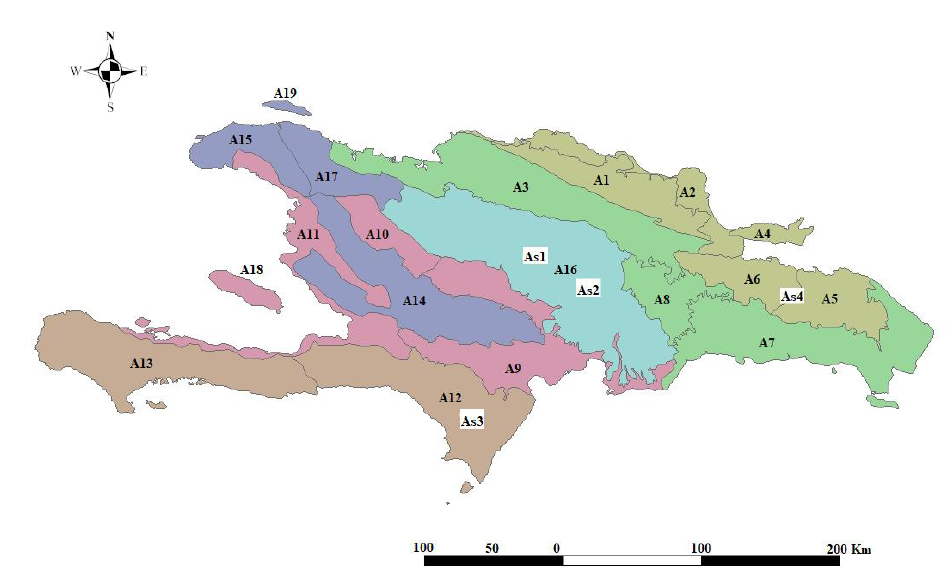
Figure 4. Biogeographical distribution of the associations in the study. As1: Hyeronimo montanae - Magnolietum pallescentis (A16: central district). As2: Cyatheo furfuracei - Prestoetum montanae (A16: central district). As3: Hyeronimo dominguensis - Magnolietum hamorii (A12: Bahoruco district). As4: Ormosio krugii - Prestoetum montanae (A5: eastern district) (from Cano–Ortiz et al., modified [28]). Table 3. Synthetic table of the four new associations considered in this study. Species As1 As2 As3 As4 P Myrsine coriacea (Sw.) R. Br. IV III V III 4 Ocotea leucoxylon (Sw.) Mez I IV III III 4 Prestoea montana (Grah.) Nichol I V V V 4 Psychotria domingensis Jacq. IV IV V III 4 Gleychenia bifida (Willd.) Spreng. II I - I 3 Clidemia umbellata (Miller) L.O. Wms. I I - I 3 Renealmia jamaicensis (Gaertn.) Horan var. puberula (Gagn.) Maas V III V - 3 Arthrostylidium multispicatum Pilger V IV III - 3 Rondeletia ochracea Urb. V II V - 3 Didymopanax tremulus Krug. & Urb. IV I V - 3 Psychotria guadalupensis (DC.) Howard Mikania venosa A. Liogier Brunellia comocladifolia H. & B. Alchornea latifolia Sw. - Mucuna urens (L.) Fawc. & Rendle - II Nephrolepis multiflora (Roxb.) Jarret - I III I 3 Ilex macfadyenii (Walp.) Rehder V - I - 2 Chionanthus domingensis Lam. V - I - 2 Macrocarpaea domingensis Urb. IV - III - Polygala fuertesii (Urb.) Blake IV - III - Marcgravia rubra A. Liogier IV - I - Alsophila minor (D. C. Eaton) R. M. Tryon V Palicourea alpina (Sw.) DC.